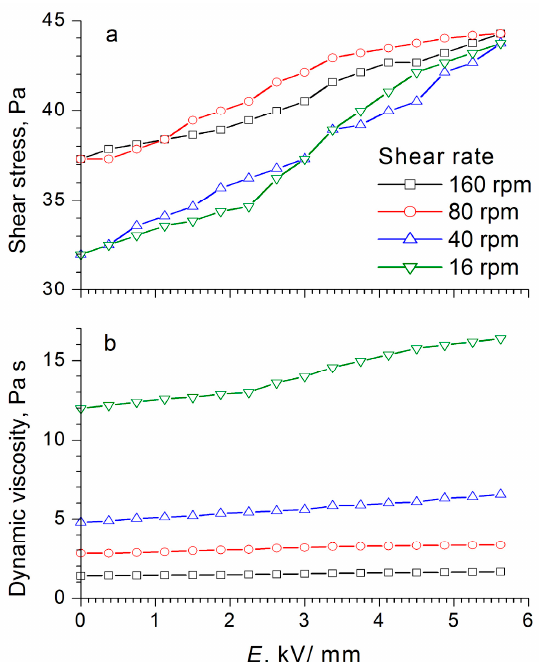
Figure 8. Dependence of ( a ) shear stress and ( b ) dynamic viscosity of the electrorheological fluid containing 60 wt% WO 3 on the electric field strength, at different shear rates.